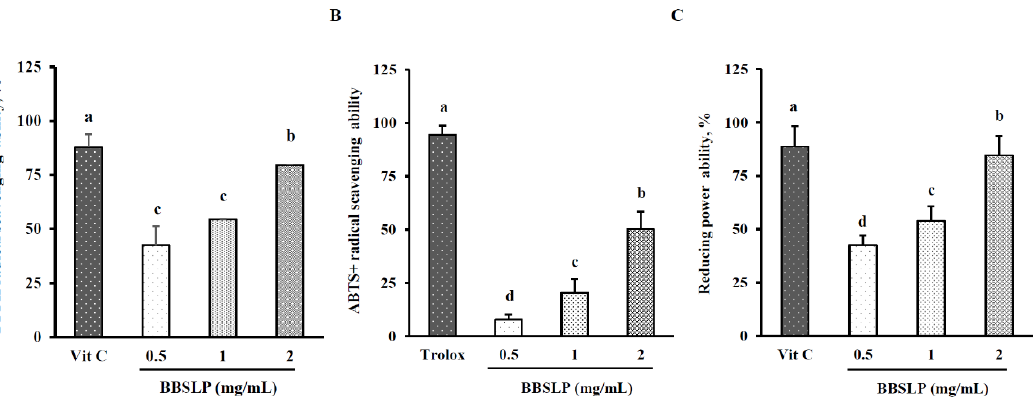
Figure 1. In vitro antioxidative ability of the BBSLP. DPPH radical scavenging activity ( A ), ABTS + radical scavenging activity ( B ) and reducing power ( C ). Vitamin C was used as the positive control in the DPPH radical scavenging assay and reducing power ability assay, Trolox was used as the positive control in the ABTS + radical scavenging. Values are presented as means ± SD ( n = 3–5). abc Values are significantly different from the other groups as determined by Duncan’s test ( p < 0.05). Black bean steamed liquid lyophilized product (BBSLP).